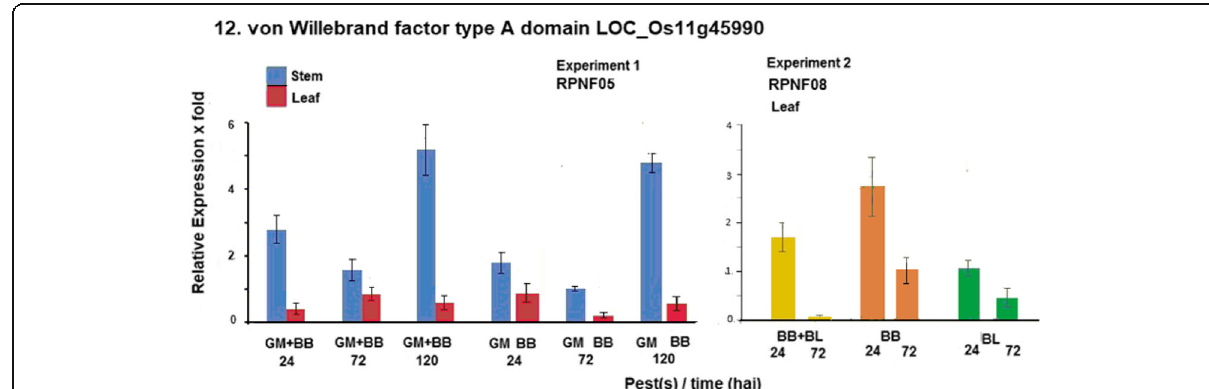
Fig. 5 Relative levels of expression of von Willebrand factor type A domain protein gene in rice line RPNF05 following challenge by BB and/or GM (Experiment 1) or in RPNF08 following BB and/or BL infection (Experiment